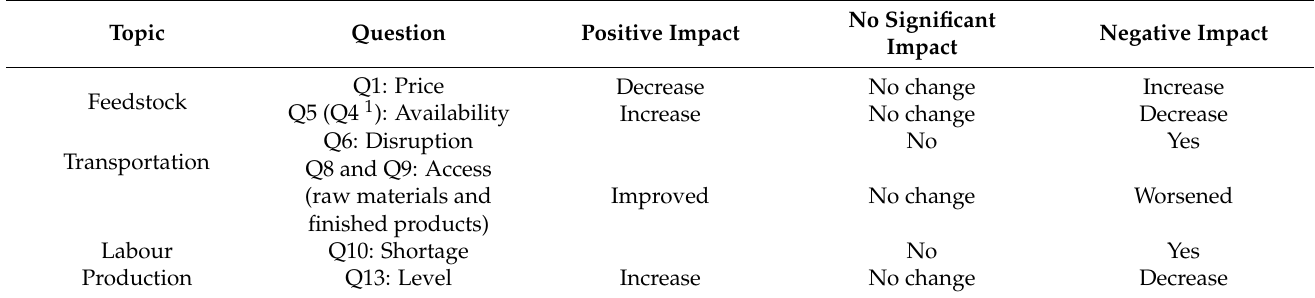
Table 1. Classification of topics and answers used to aggregate survey